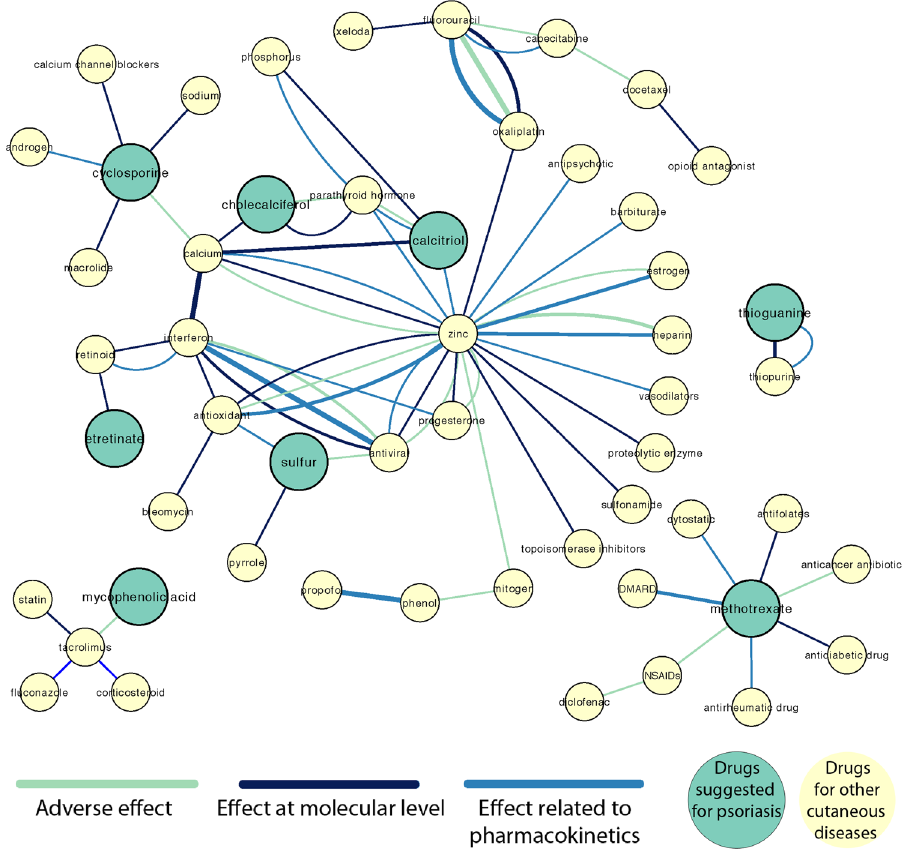
Figure 3. ADR network for cutaneous diseases showing interaction between NDFRT drugs suggested for cutaneous diseases and drugs. Thickness of the edges correlate with the number of instances to support the ADR